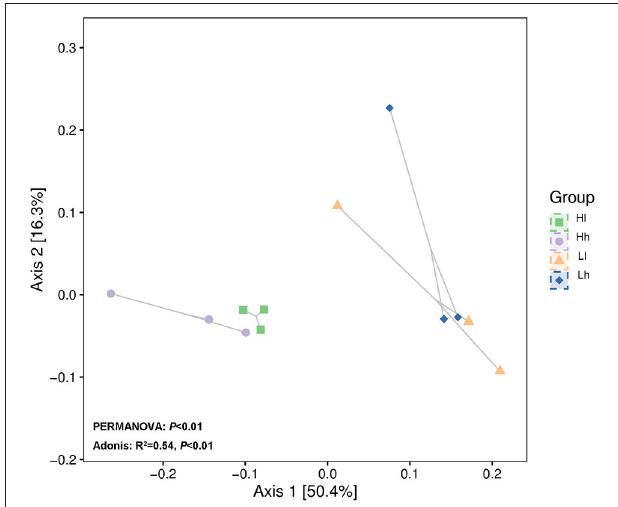
FIGURE 8 | Principal coordinates analysis (PCoA) revealing bacterial genera in groups with different combinations of sugar and starch levels based on Bray–Curtis (Hl, Diet of high starch and low sugar; Lh, Diet of low starch and high sugar; Hh, Diet of high starch and high sugar).